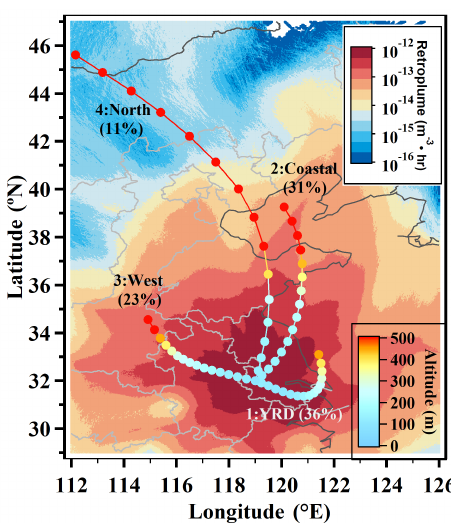
Figure 8. The average back-trajectories of the clusters obtained from the back-trajectory cluster analysis for the winter period 1 November 2013–28 February 2014. The duration of the trajectories is 48h. The average 72h retroplume for the same period is depicted with the background